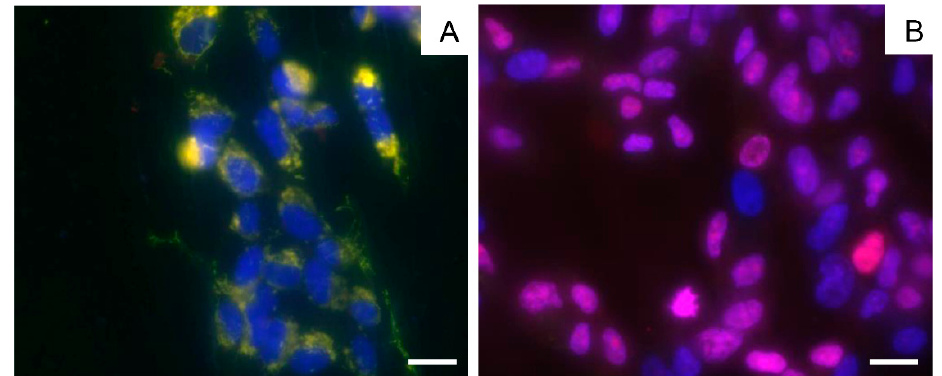
Figure 5. Micrographs of the BMSC culture before plasma treatment ( A ) and 24 h after exposure to LTP ( B ), obtained by an overlay of three fluorescent channels and transmitted light. Cytoplasm is colored green, viable cell nuclei are colored blue (Hoechst 33342) and a pink color (propidium iodide) indicates apoptotic cell nuclei. The scale bars are 20 μ M.